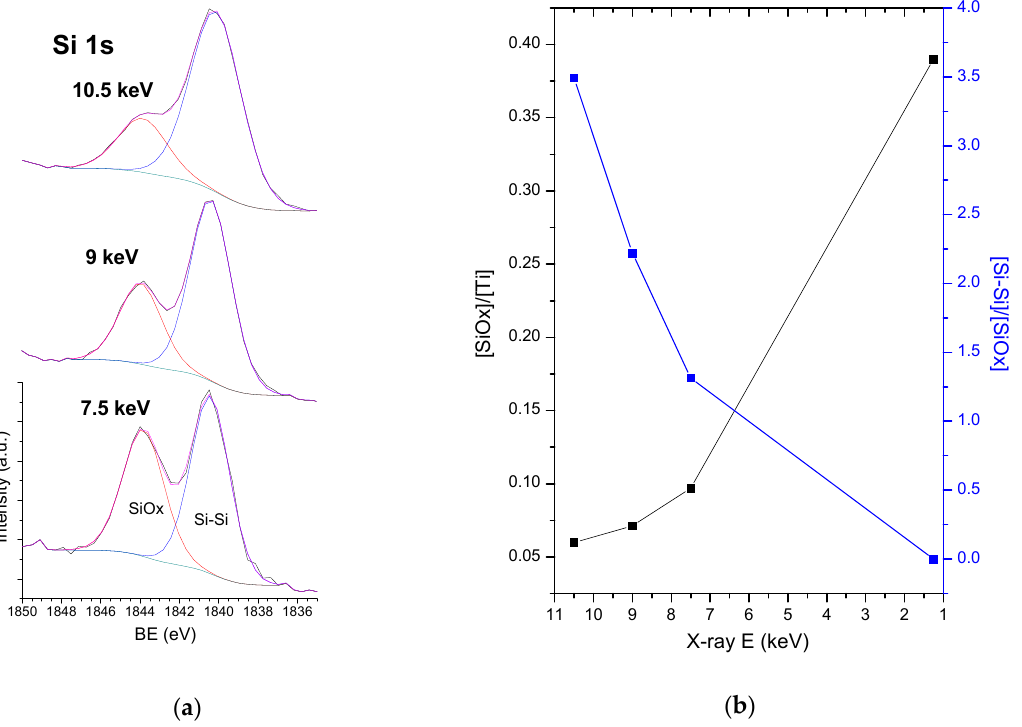
Figure 8. HAXPES analysis of a PFDS / TIPT xerogel film. ( a ) Experimental and fitted spectra of the Si 1s peak obtained at 7.5, 9.0 and 10.5 x-ray beam energy (from bottom to top). ( b ) Evolution of [SiO x ] / [Ti] and [Si-Si] / [SiO x ] as a function of x-ray beam energy. Note inclusion of additional data from conventional XPS analysis.